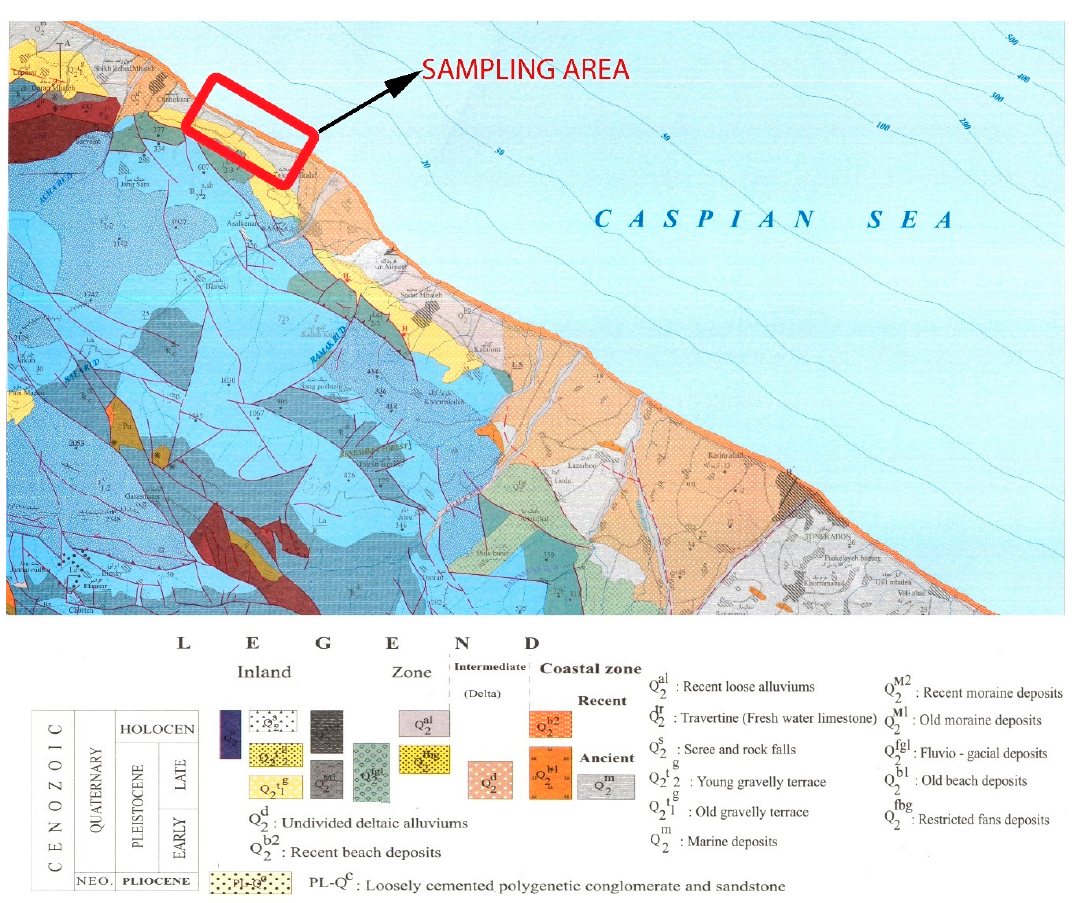
Figure 3. Geological and structural map of the sampling area (taken from 1:100,000 maps of Chalous, Shokran, Marzanabad, Baladeh and Ramsar, Geological Survey of Iran).